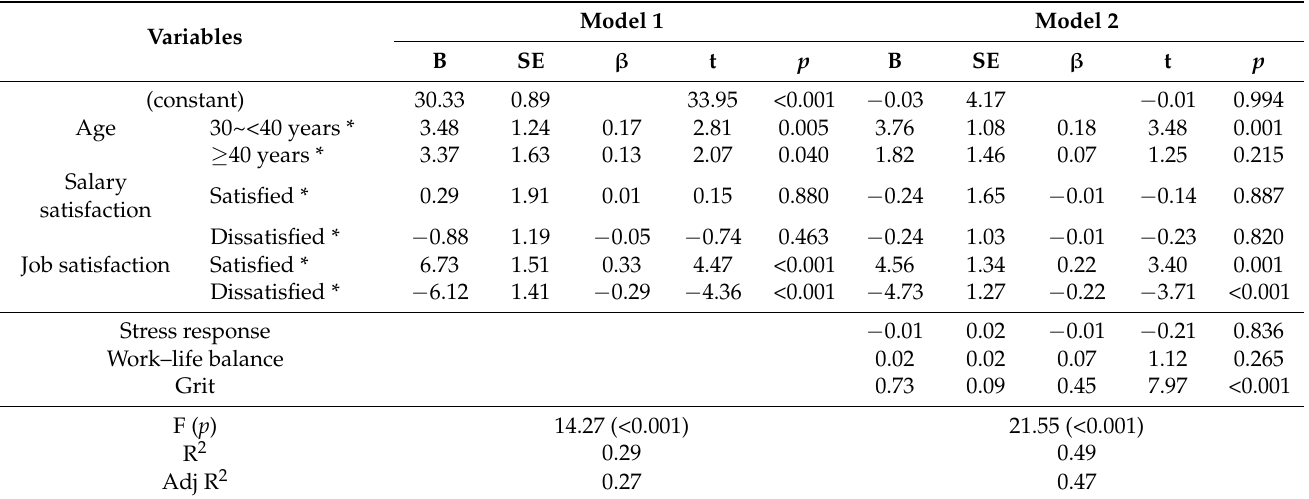
Table 3. Factors affecting retention